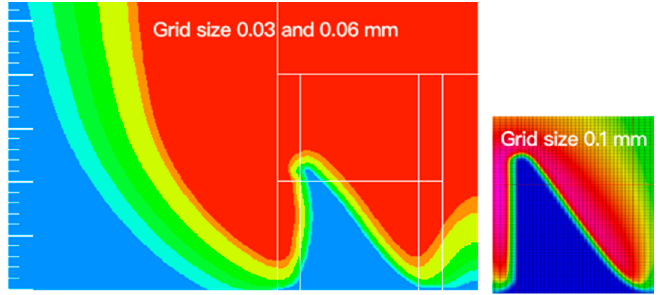
Figure 3. The temperature distribution for different grid sizes. The burning condition was at jet spacing of 2d, a burner average inlet flow speed of 1 m / s, and an equivalence ratio of